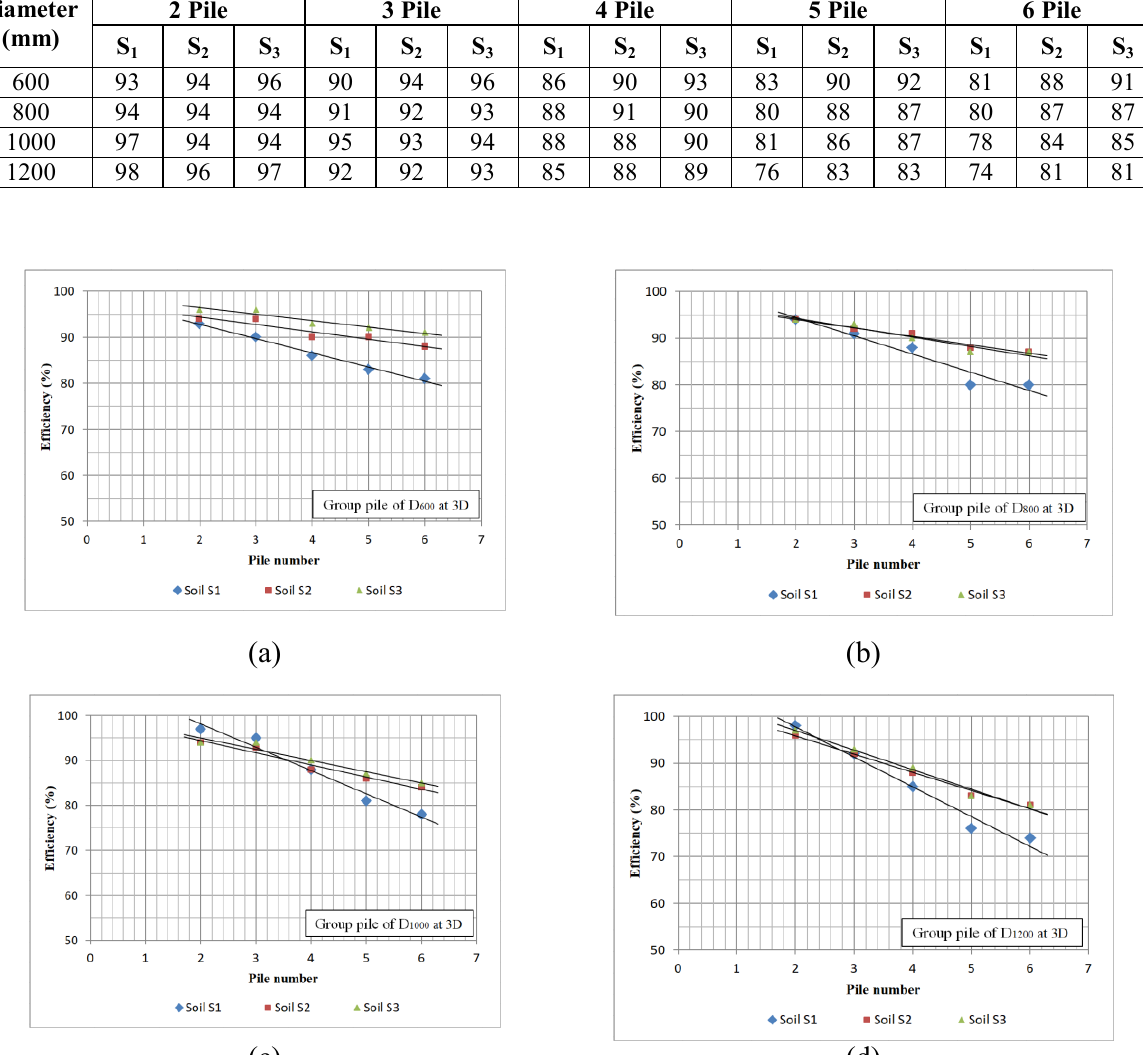
Fig. 5. Variation of group pile efficiency with different pile numbers of (a) diameter 600mm, (b) diameter 800mm (c) diameter 1000mm and (d) diameter